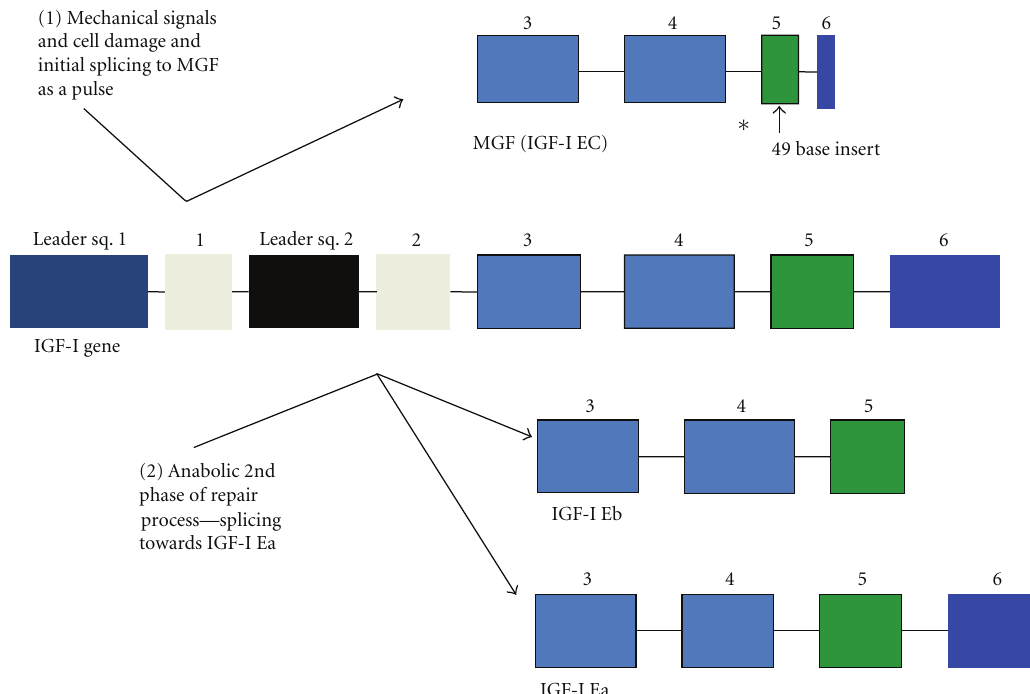
Figure 1: Schematic representation of the splicing of the human IGF-I gene in human muscle to produce human MGF (IGF-1Ec) as well as IGF-IEa and IGF-IEb. The IGF-I gene has two start sites located in or near exons 1 and 2. In response to a exercise/damage the IGF-I gene is first spliced to produce MGF. This involves a reading frame shift that results in the unique carboxy terminal sequence (E domain) of MGF (IGF-I Ec). The expression of the IGF-I gene is initiated by certain hormones, and this becomes a problem as during aging GH and testosterone levels decrease resulting in decreasing levels of the primary transcript so less can be spliced to MGF when the muscle is mechanically challenged. Also it appears that the mechanotransduction and signalling system that is upstream of the activation of the IGF-I gene also become less sensitive, and less MGF is